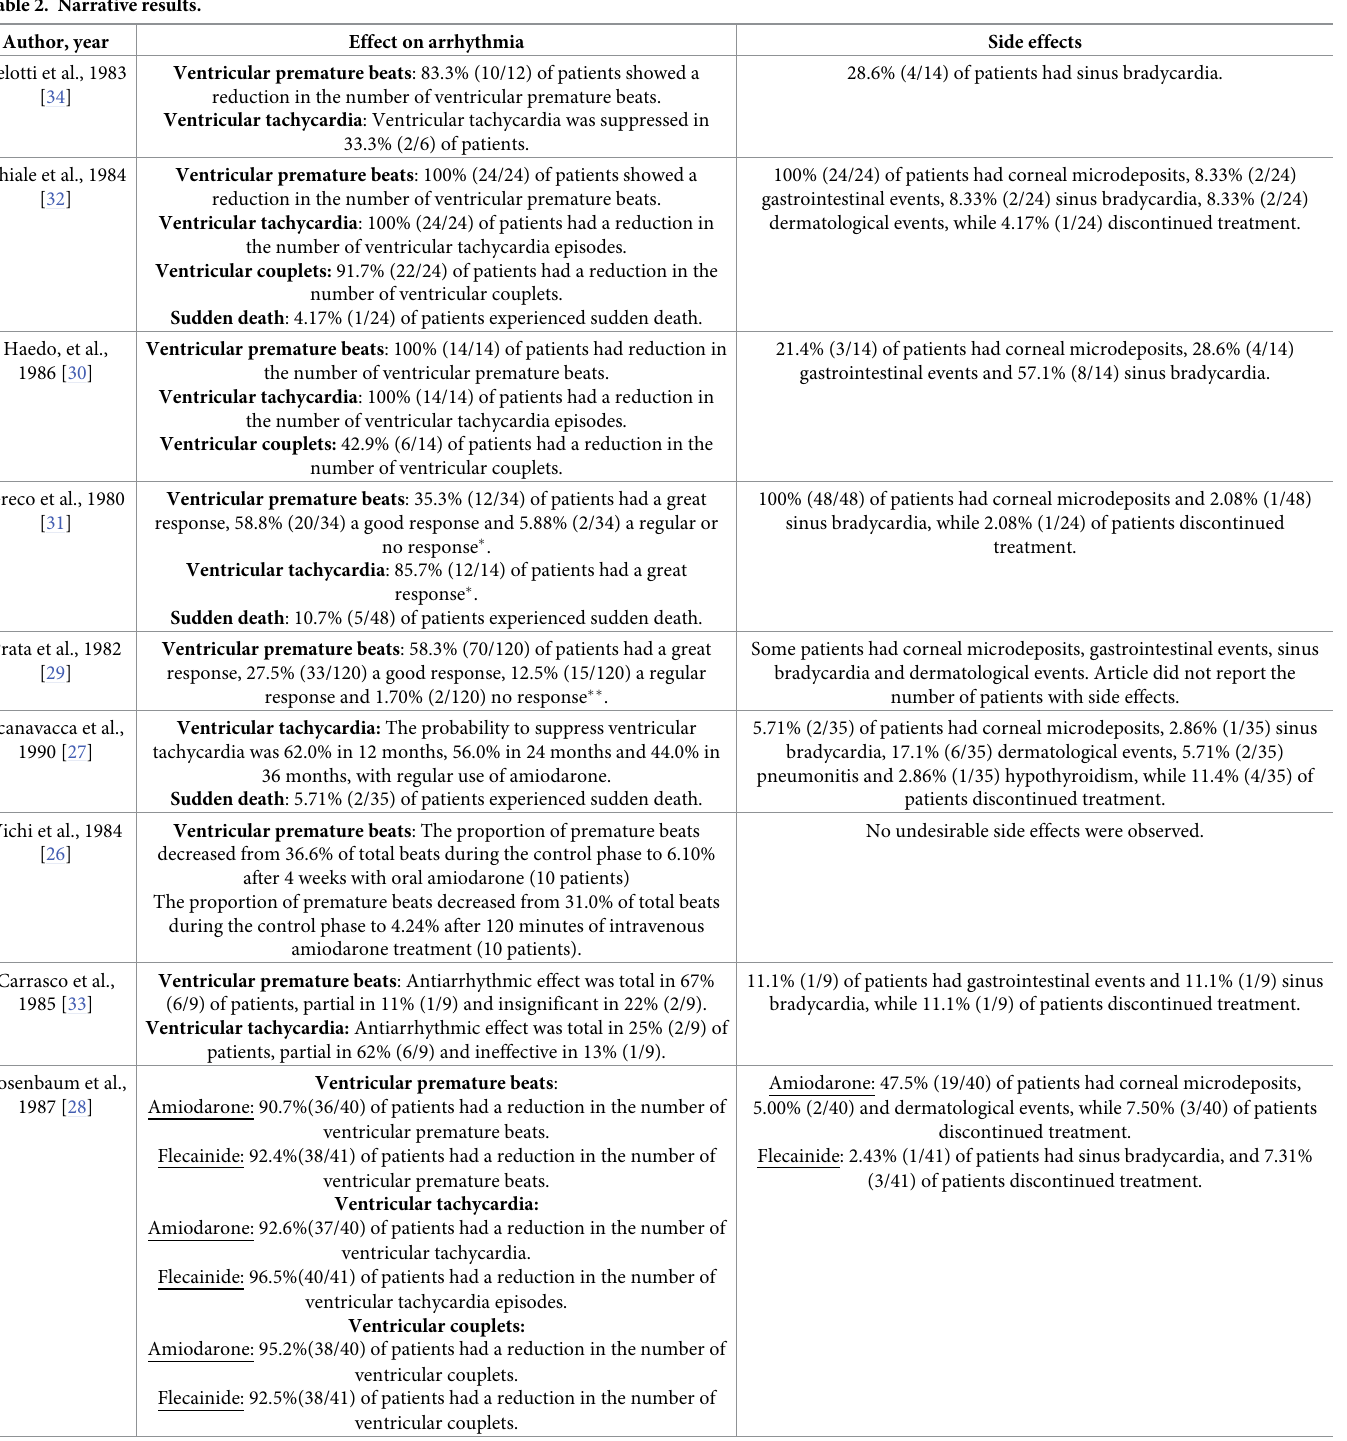
Table 2. Narrative